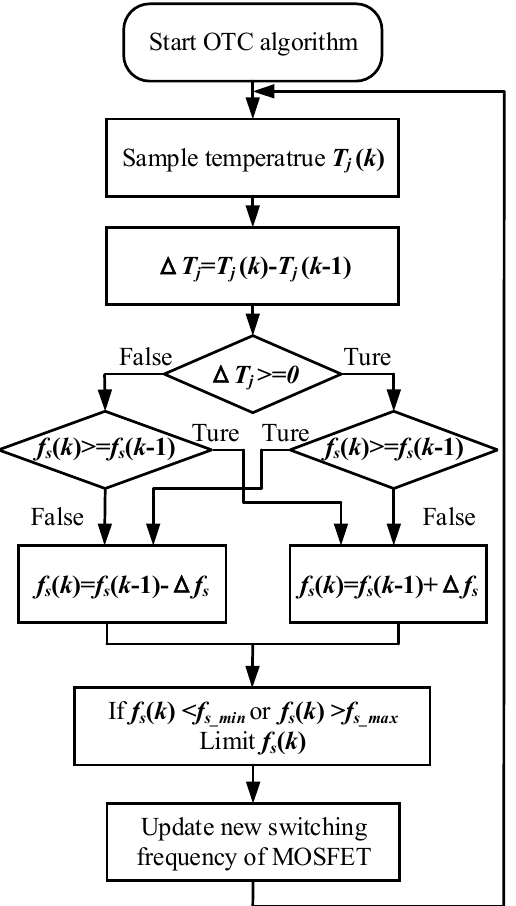
Figure 7. Flowchart of the proposed control algorithm.